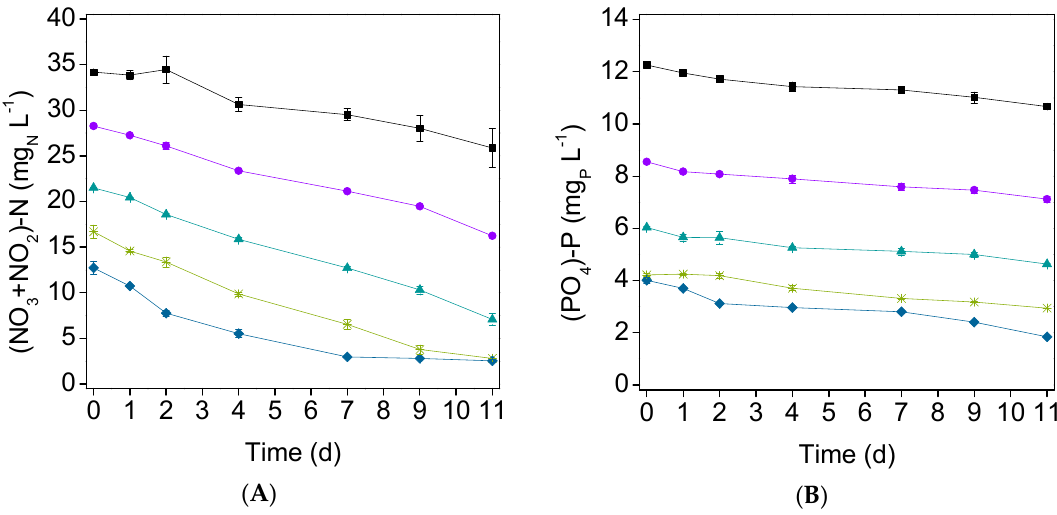
Figure 3. Temporal variation of ( A ) nitrogen (nitrate + nitrite) and ( B ) phosphorus (phosphate) concentration determined in C. vulgaris cultures grown in raw and diluted secondary-treated paper industry effluent (Assays: 1 , 2 , 3 , 4 and 5 ). Error bars correspond to the standard deviation of the mean obtained from two independent experiments.